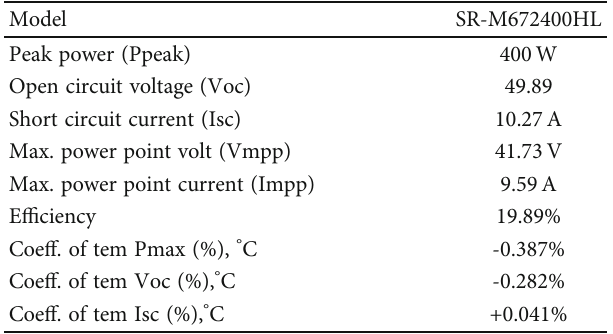
Table 3: PV panel